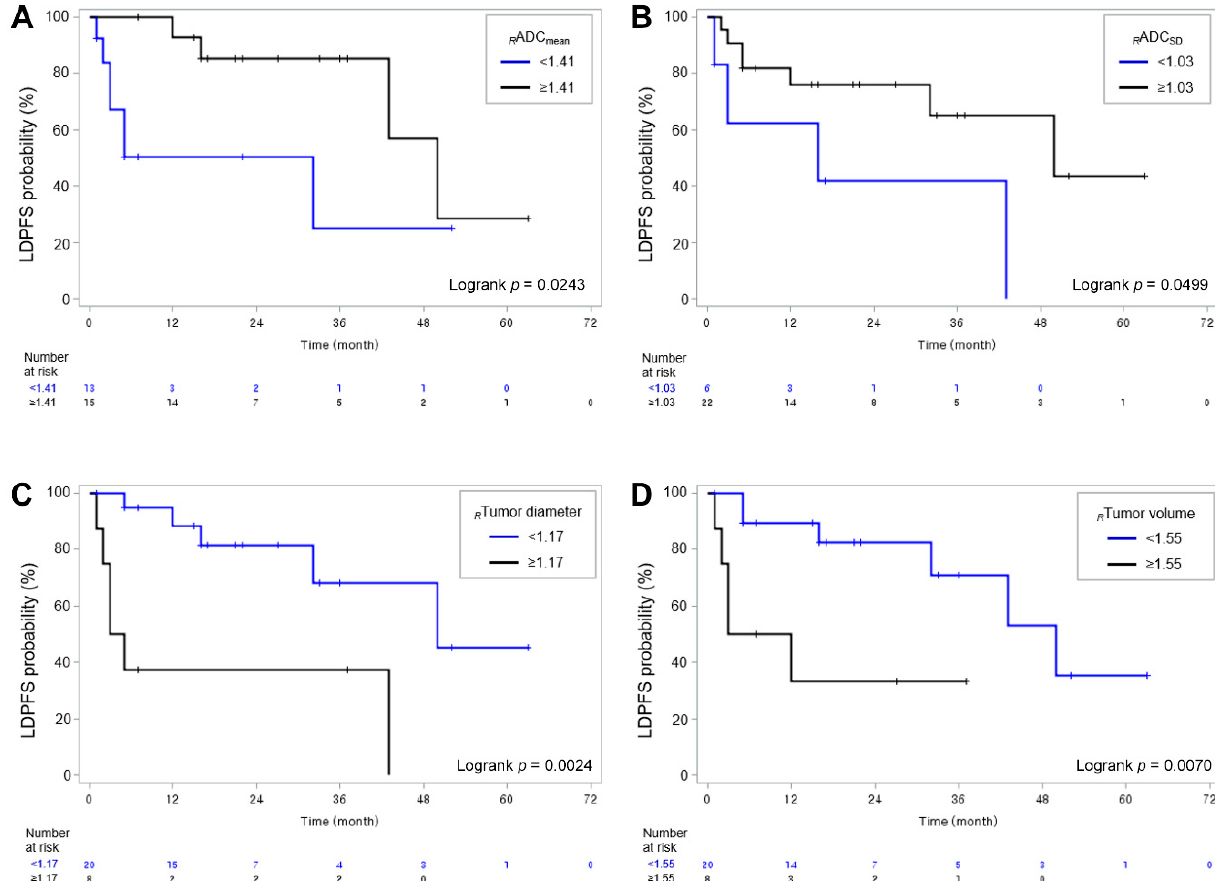
Figure 2. Kaplan–Meier curves showing LDPFS of patients according to ( A ) R ADC mean , ( B ) R ADC SD , ( C ) R Tumor diameter, and ( D ) R Tumor volume with their cutoff values. LDPFS, local disease progression-free survival; ADC, apparent diffusion coefficient; SD, standard deviation.